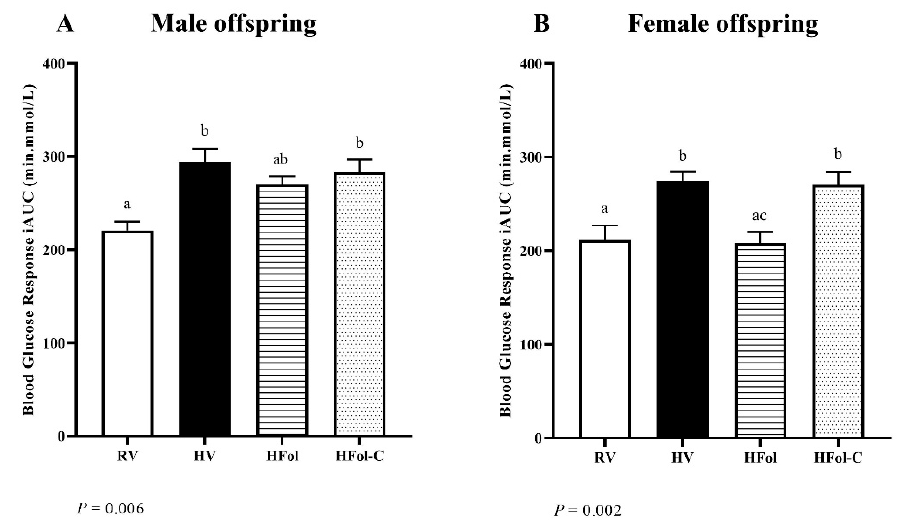
Figure 5. Blood glucose response to a glucose load (5 g of glucose per kg of body weight) as incremental area under the curve (iAUC) in ( A ) male and ( B ) female offspring at 9 weeks post-weaning. Diet abbreviations: RV, recommended vitamin; HV, high multivitamin; HFol, high folic acid with recommended choline; HFol-C, high folic acid without choline. Superscripts indicate p ≤ 0.05 by one-way ANOVA followed by the Tukey–Kramer post hoc test, n = 10–12/group. Values are mean ± SEM.